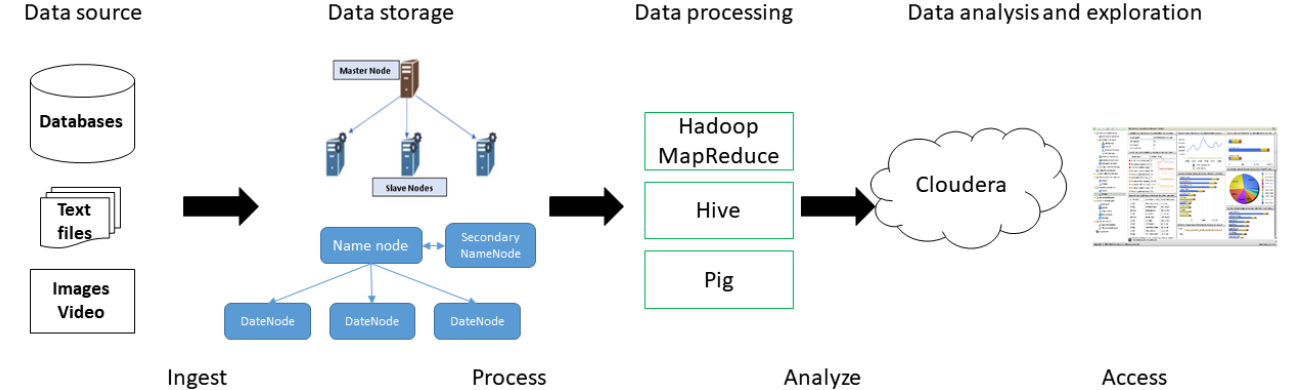
Figure 5. Hadoop framework architecture and components